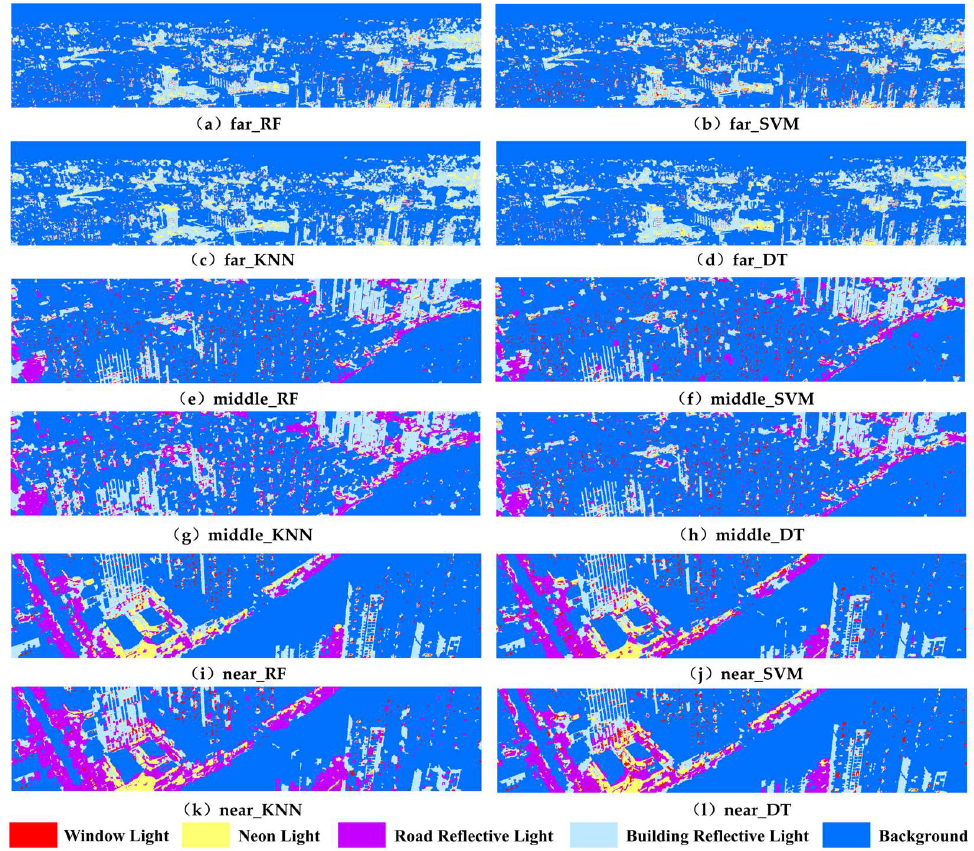
Figure 6. Fine-grained classification results of four machine learning algorithms for urban nighttime lights in near, middle and far view regions.